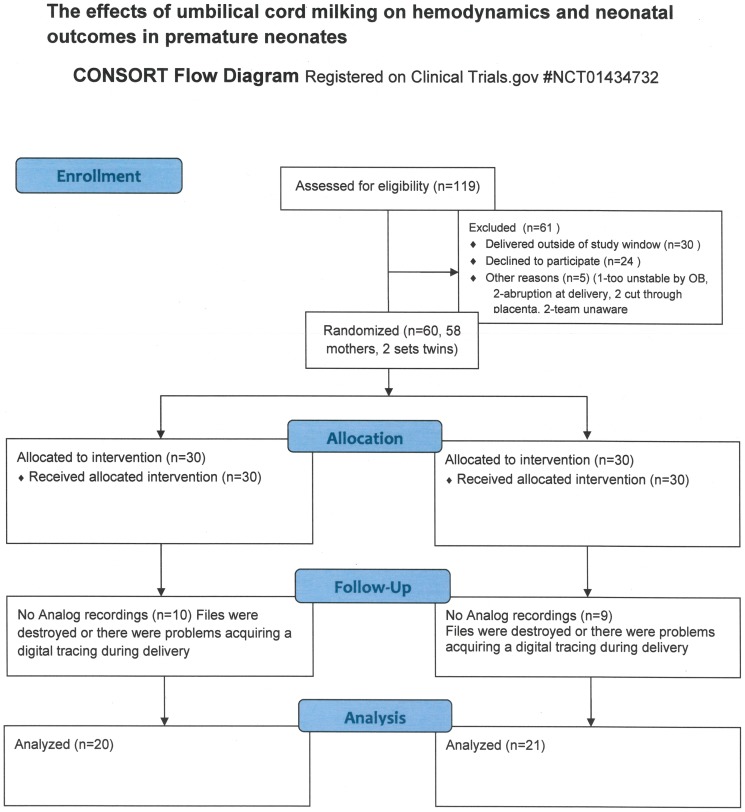
Consort Diagram.